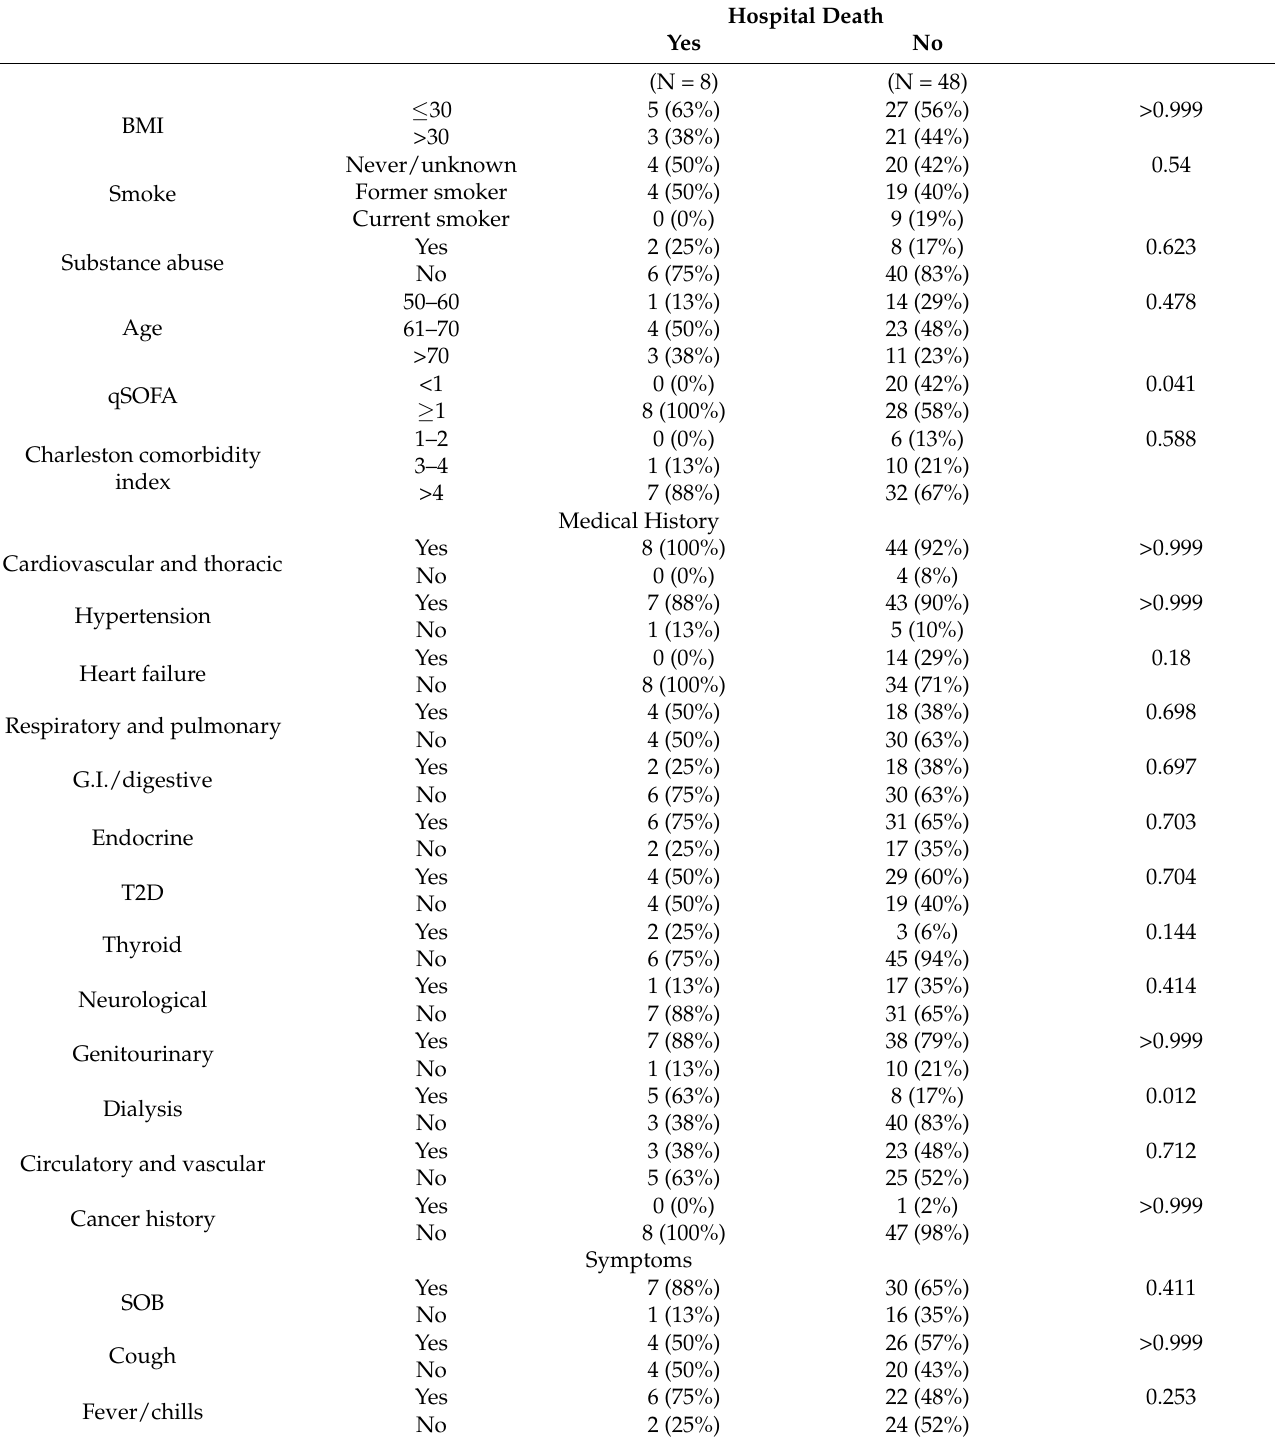
Table 2. COVID-19 patient characteristics by in-hospital